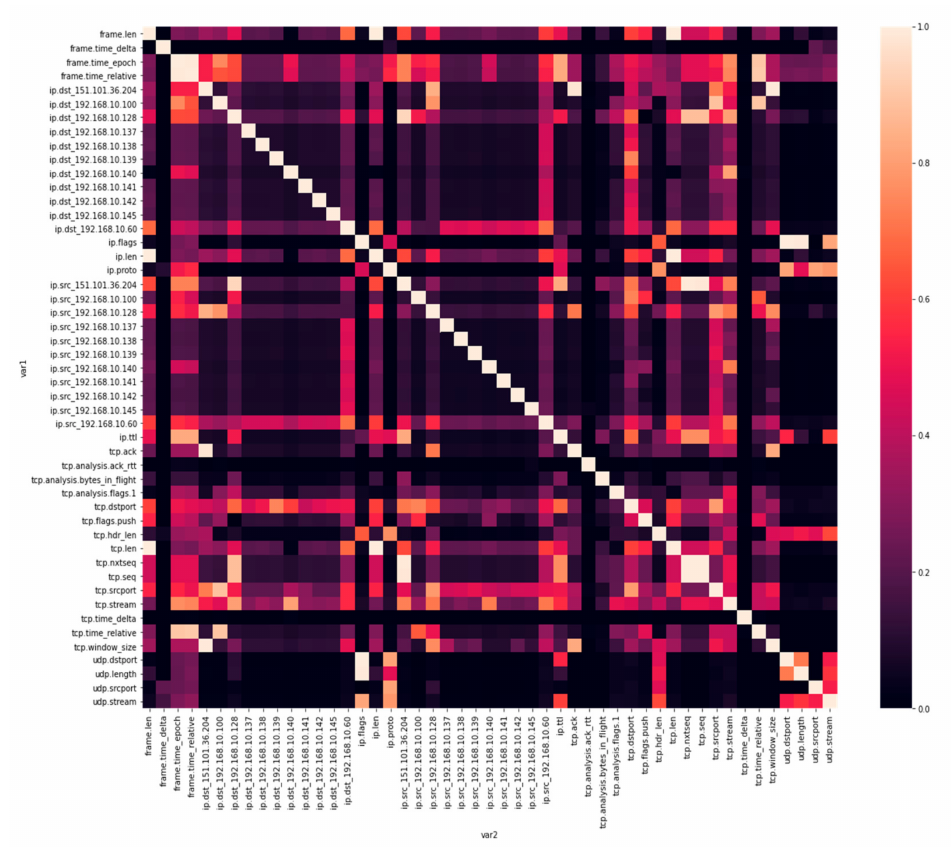
Figure 5. Heatmap showing correlation